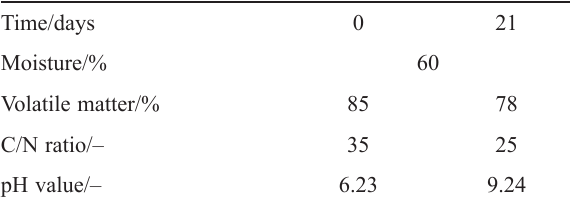
Table 3 – Physicochemical characterisation of the mixture of waste (W) at the beginning and end of the composting process